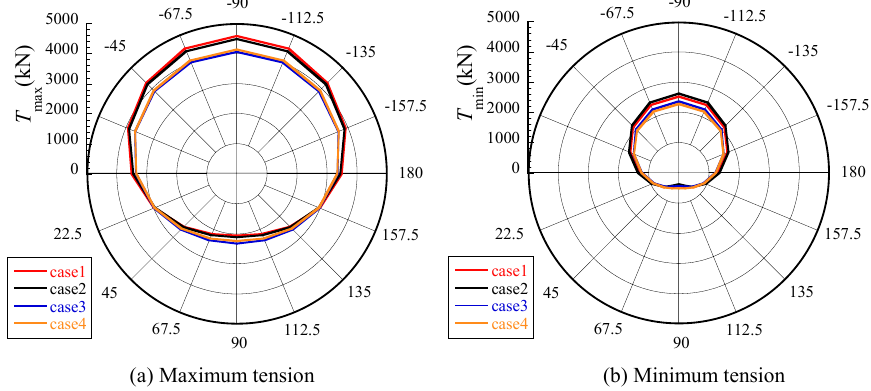
Fig. 6 Tensions in tendon No. 1 for wind direction θ ( L : D p : H p = 30 m: 6 m: 23 m; T 0 = 2290 kN under storm